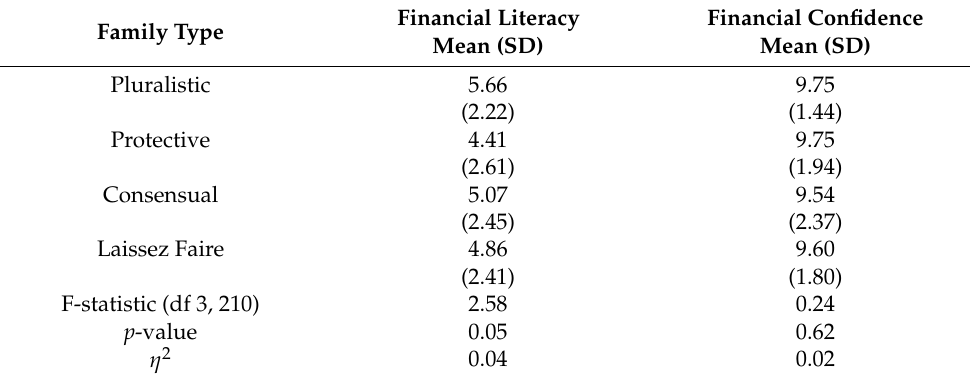
Table 4. Summary statistics of ANOVA